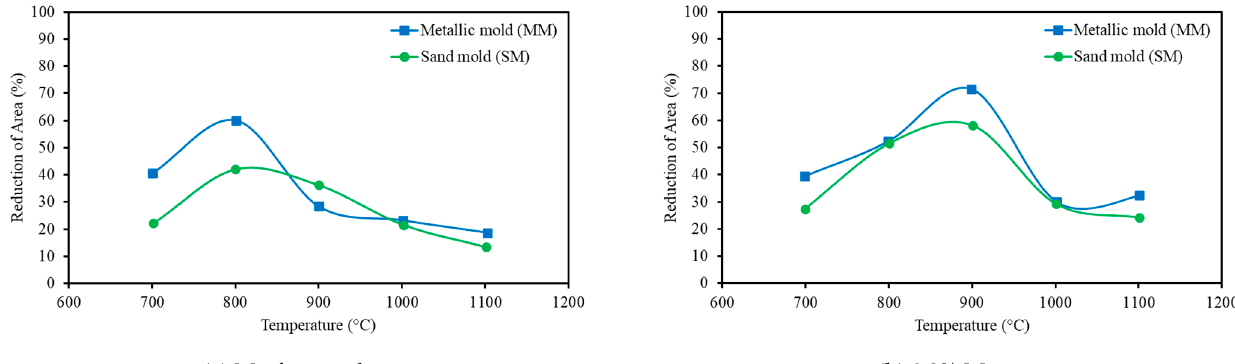
Figure 4. Hot ductility curves of the as-cast TWIP steel, having a base composition of 0.5% C, 21% Mn, 1.3% Si, 1.5% Al, and 0.012% N: ( a ) with no Mo present in the steel; ( b ) a 0.3% Mo addition. Tensile specimens were machined from sand molds or ingot castings, so as to give two cooling rates, a slow cooling rate with the sand molds and a fast cooling rate with the metallic molds. The 0.3% Mo addition can be seen to improve ductility in the intermediary temperature range of 800 to 950 °C, independent of the cooling conditions [13]. Adapted from [13], with permission from Elsevier, 2023.